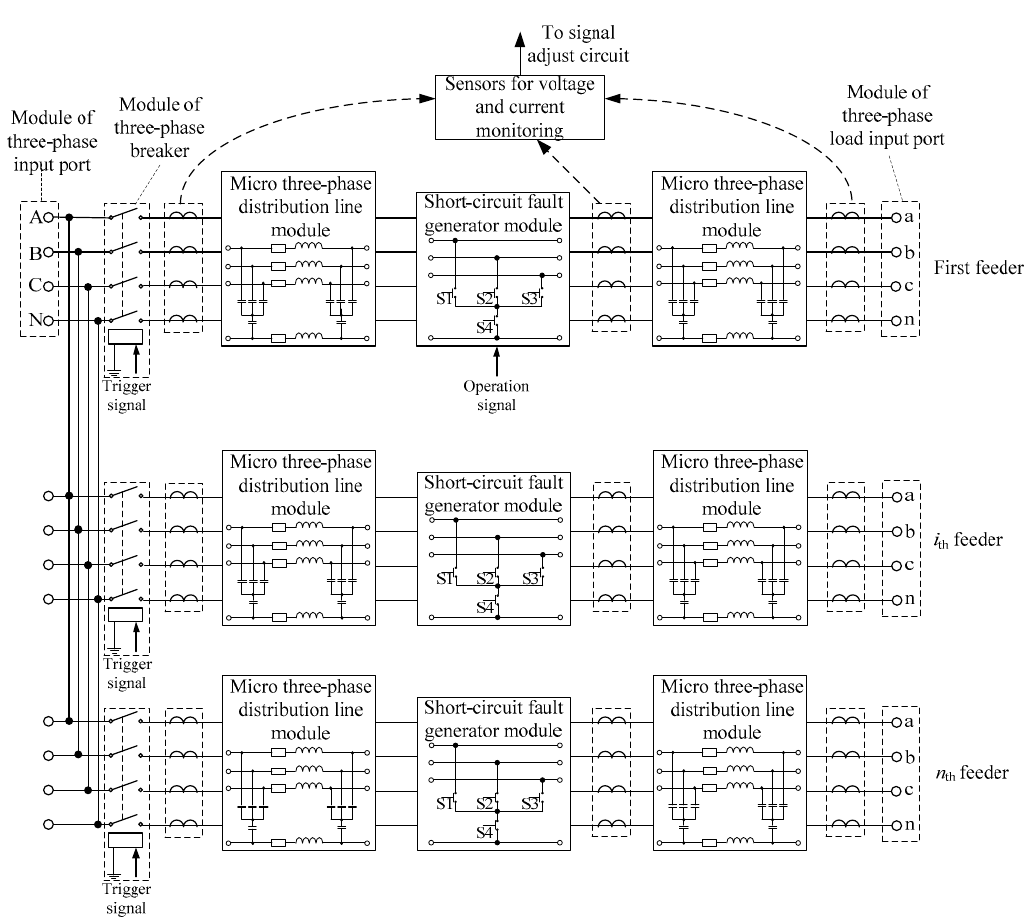
Figure 1. Architecture of the proposed integrated power distribution system laboratory platform. Energies 2019 , 12 , x FOR PEER REVIEW 5 of 19